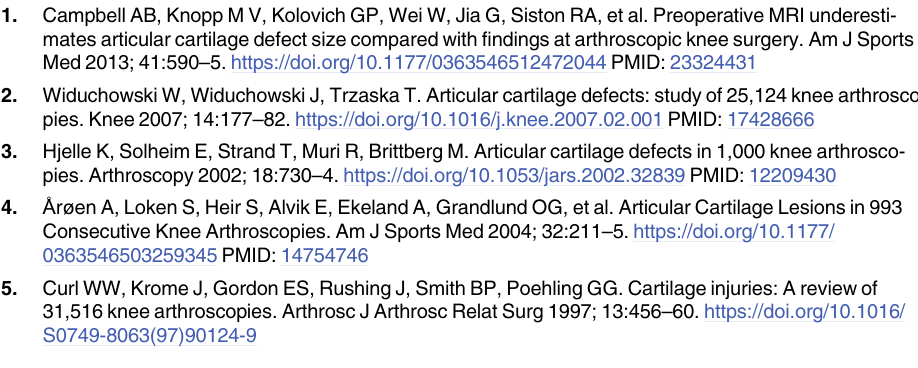
S2 Table. The root mean squared difference between the reference and defect kinematics throughout the stance phase. S3 Table. Raw data compartimental load distribution and compressive strains. Supporting